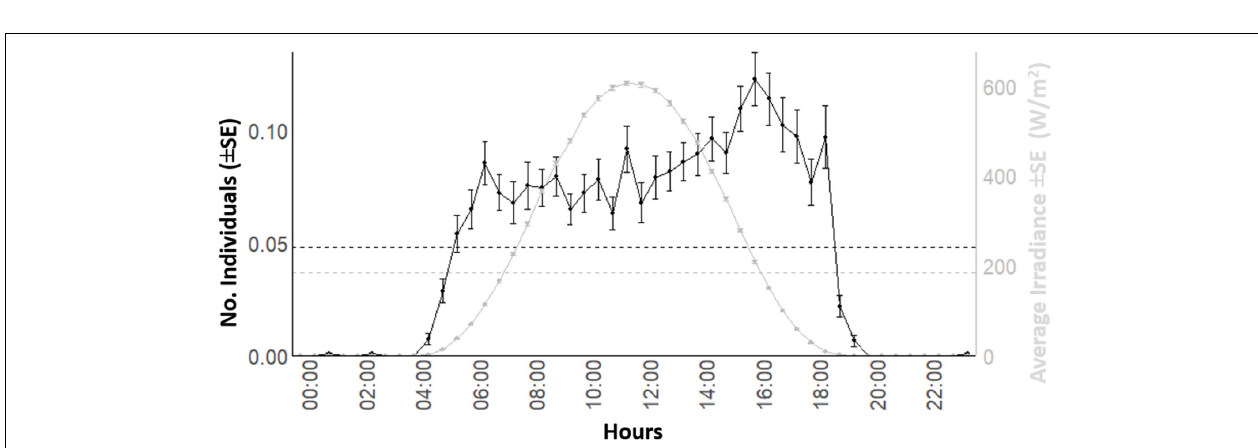
FIGURE 4 | Histogram depicting the relative percentage of images with variable number of individuals of D. dentex, where fishes of this species were present, as a quantification of grouping behavior.